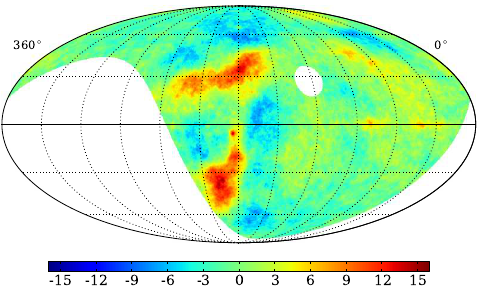
Figure 5: ARGO-YBJ sky-map in galactic coordi- nates. The statistical significance of the observation in s.d. is shown. The map center points towards the galactic anti-center.